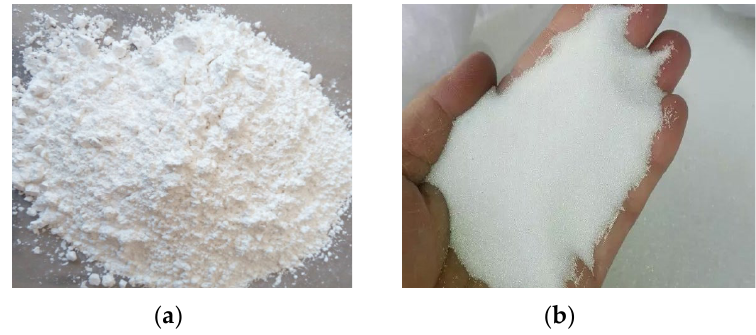
Figure 1. Glass particles: ( a ) glass powder; ( b ) glass beads.